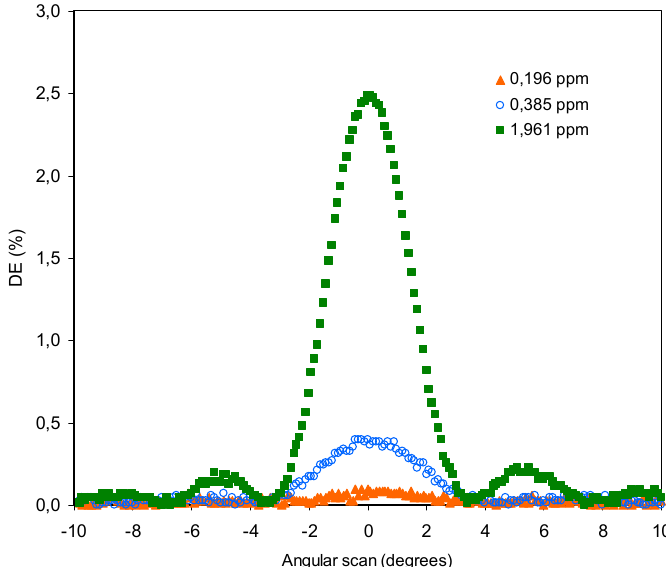
Figure 12. Diffraction efficiency versus angular scan for different concentrations of THT in the photopolymer in parts per million.